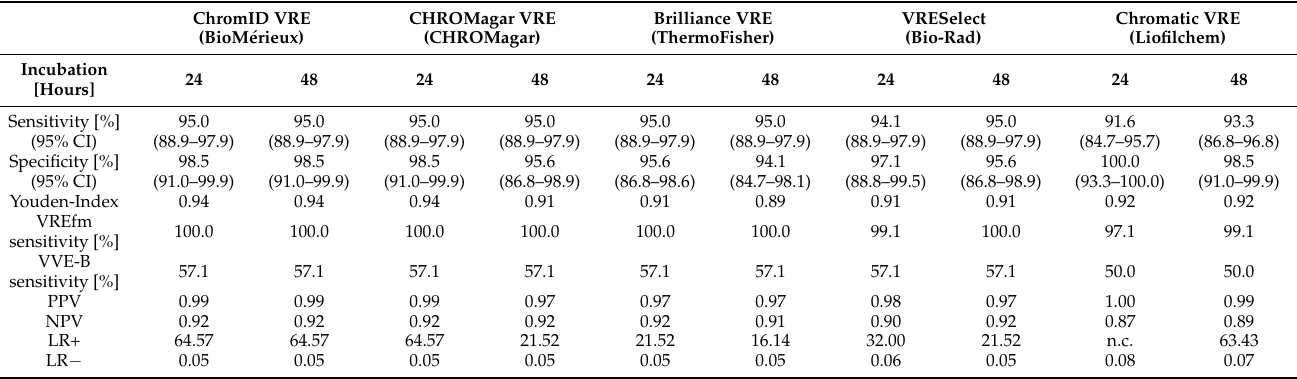
Table 2. E. faecium -specific agar plate characteristics